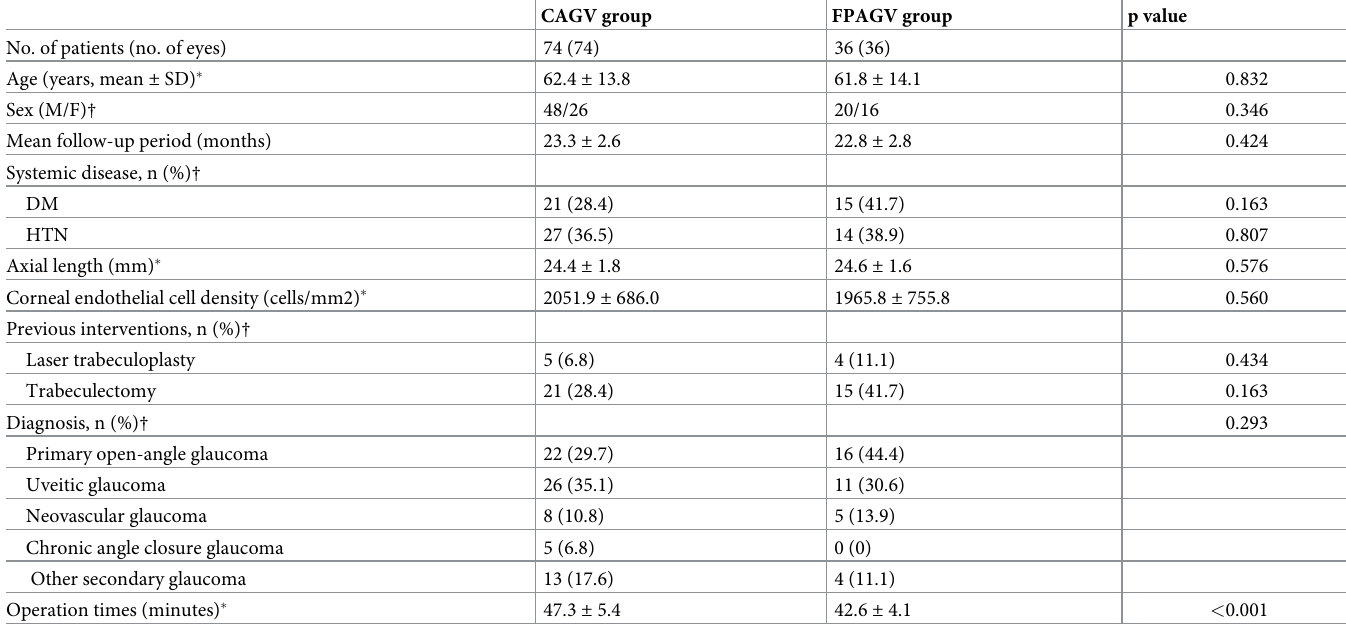
Table 1. Clinical characteristics of the study patients.